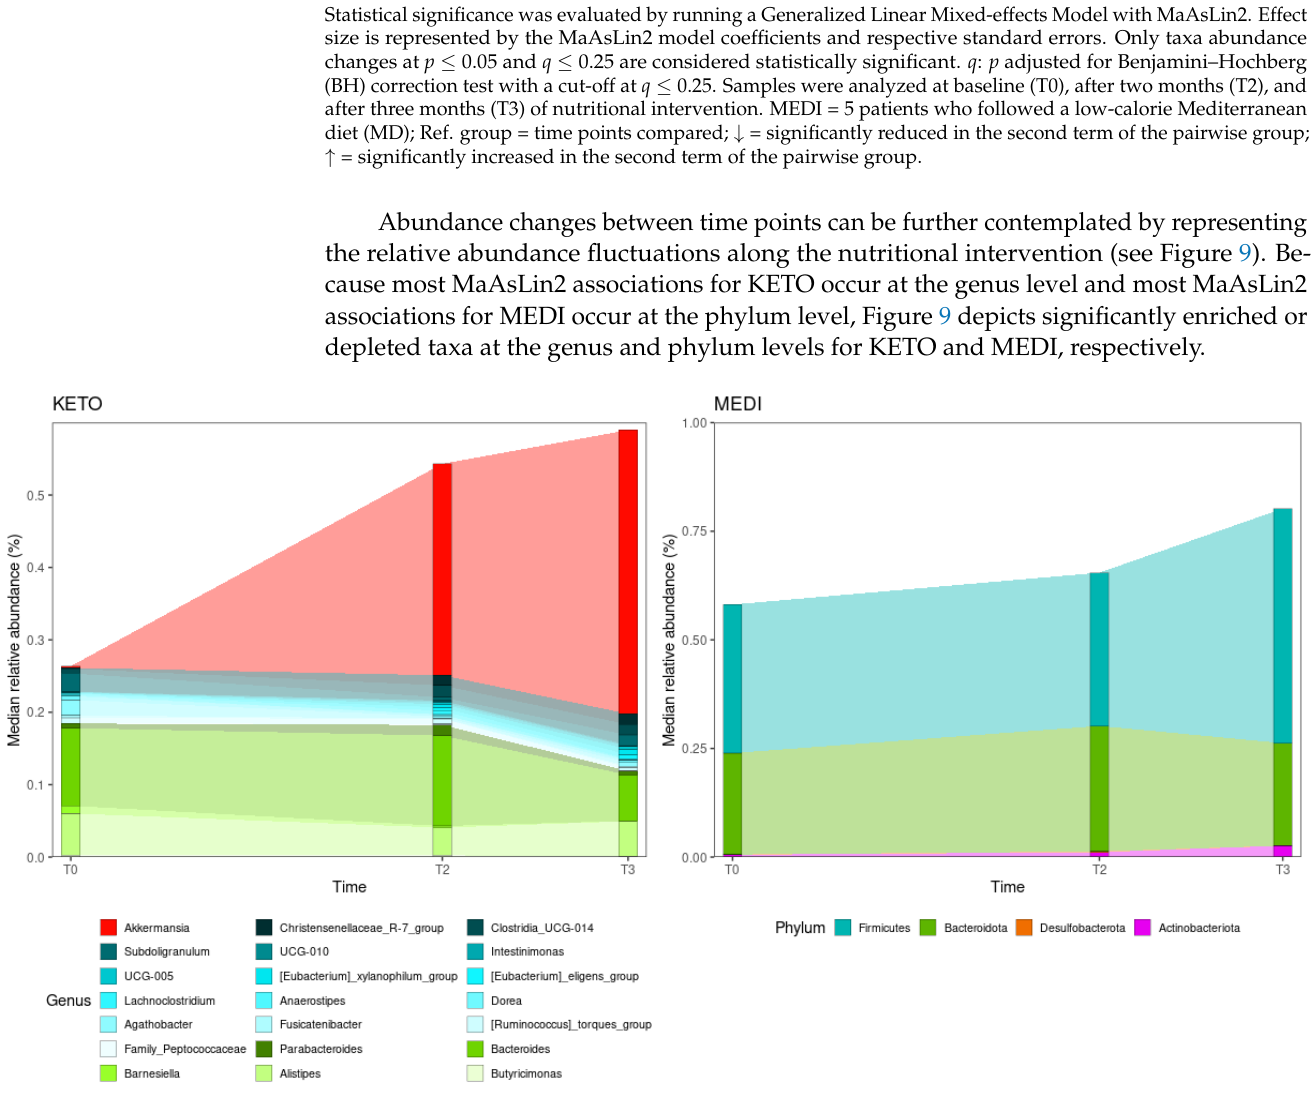
Figure 9. Relative abundance changes in gut microbiota taxa between time points for each diet. Only taxa significantly enriched or depleted during the nutritional intervention (according to MaAsLin2 models) are shown (at the genus level for KETO and at the phylum level for MEDI). Genera are colored in the KETO plot based on the phylum to which each genus belongs (red: Verrucomicrobia; blue: Firmicutes; green: Bacteroidota). KETO = 6 patients who followed a very-low-calorie ketogenic diet (VLCKD), MEDI = 5 patients who followed a low-calorie Mediterranean diet (MD). Samples were analyzed at baseline (T0), after two months (T2), and after three months (T3) of nutritional intervention.